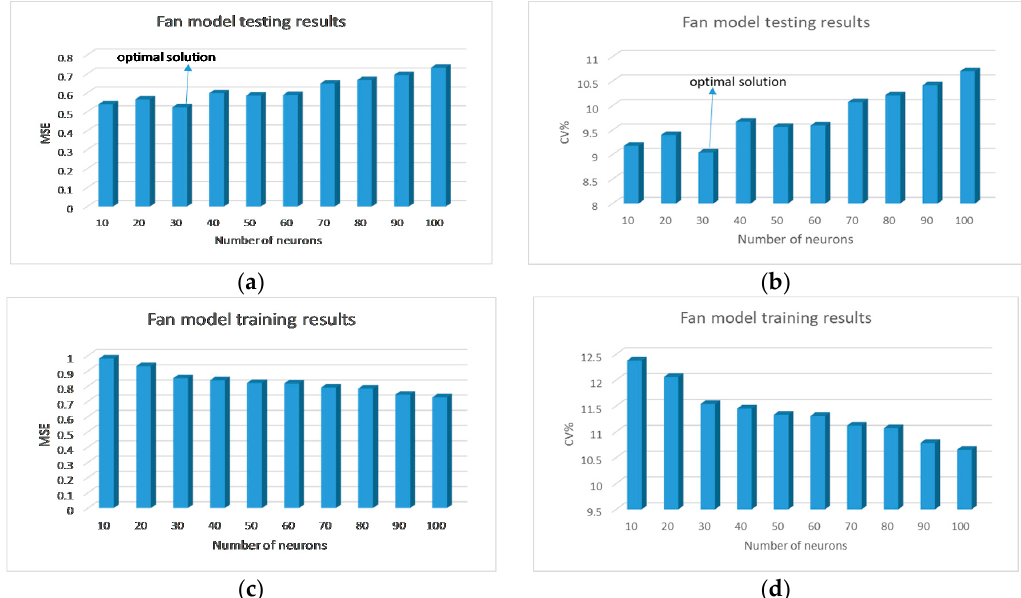
Figure 7. ( a ) MSE results for the testing period; ( b ) CV% results for the testing period; ( c ) MSE results for the training period; and ( d ) CV% results for the training period.